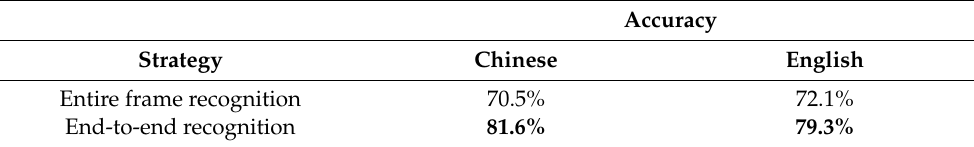
Table 1. Accuracy of Chinese and English subtitle recognition under different